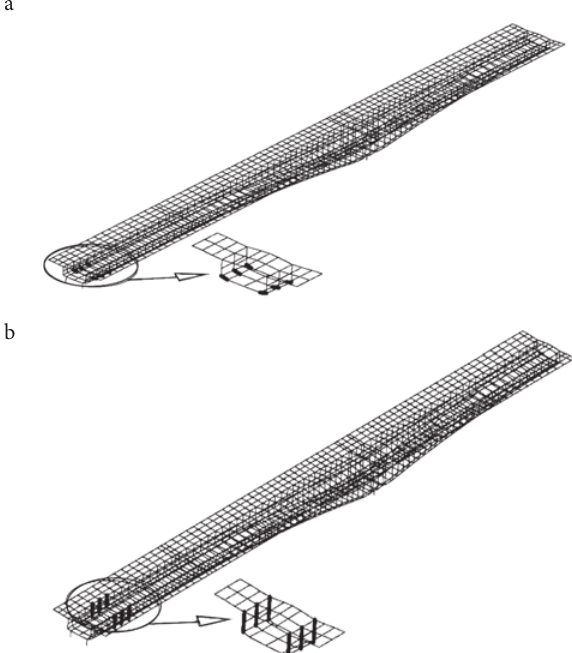
Fig. 13. Variation of normal stress of web under dead load after bottom slab